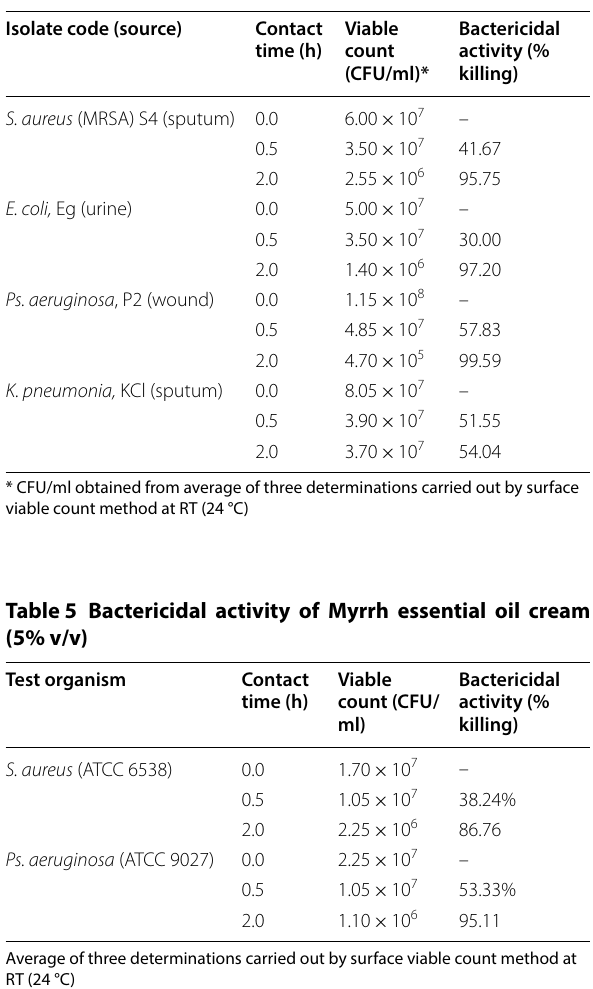
Table 4 Bactericidal activity of the essential oil of Myrrh (5% v/v) against four multidrug resistant clinical isolates Isolate code (source)